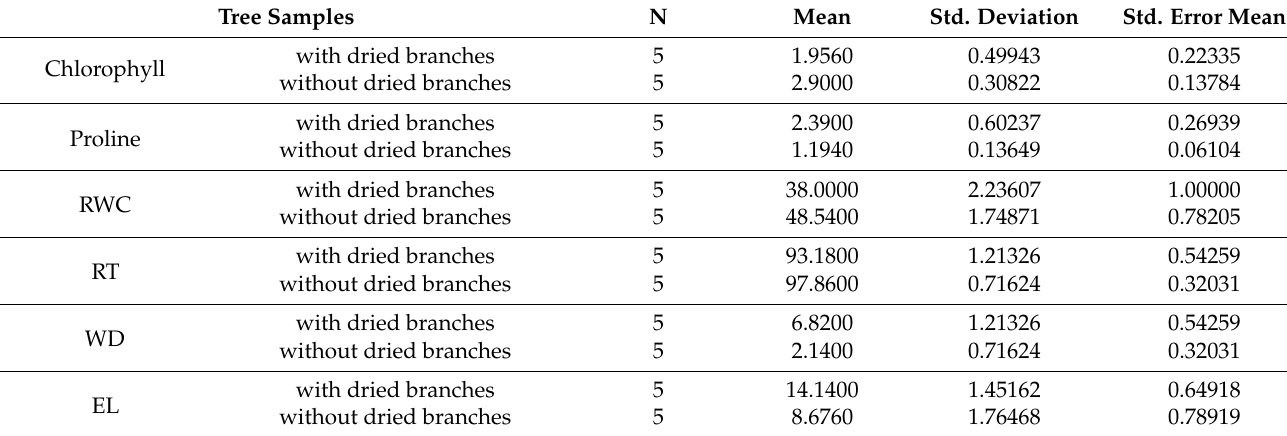
Table 4. Group statistics for investigated trees of J . seravschanica . Tree